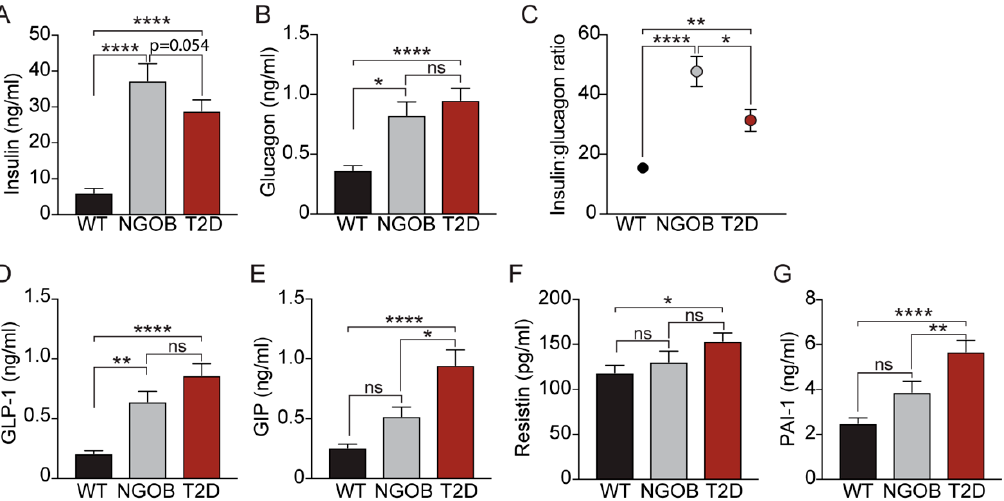
Figure 4. Loss of the insulin-glucagon ratio is associated with elevated incretin and adipokine levels in T2D: random-fed plasma concentrations of ( A ) insulin and ( B ) glucagon; ( C ) insulin-glucagon ratio; and random-fed plasma concentrations of ( D ) glucagon-like peptide 1 (GLP-1), ( E ) gastric inhibitory polypeptide (GIP), ( F ) resistin, and ( G ) gastric inhibitory polypeptide (PAI-1) in WT, NGOB, and T2D mice, n = 9–17. Data represents mean ± SEM. * p < 0.05, ** p < 0.01, and **** p < 0.0001. ns = not